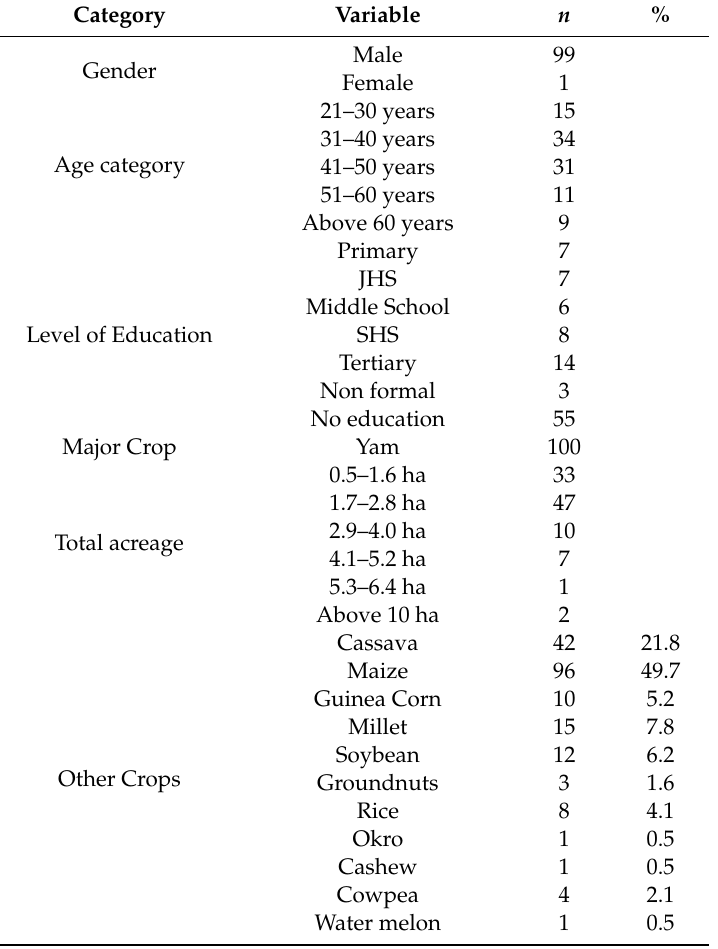
Table 1. Socio-Demographic Characteristics of